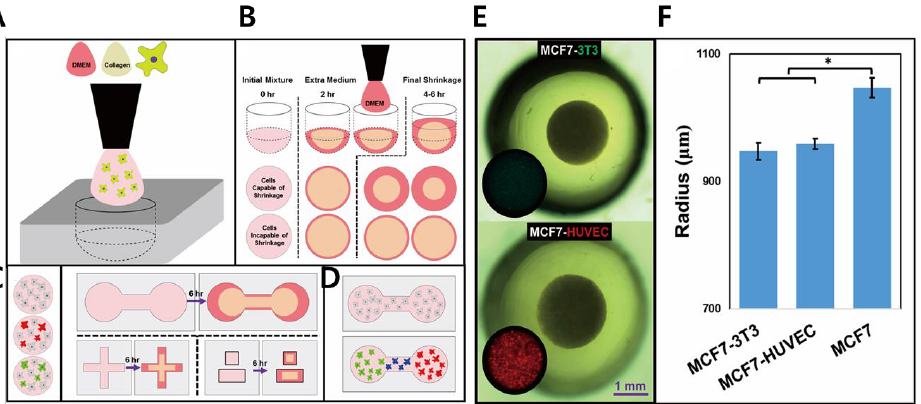
Figure 5. ( A ) Fabrication process of the collagen matrix platform. ( B ) Cell consolidation and shrinkage due to structural transformation and medium addition. ( C ) Creation of homogeneous co-culture structure with different morphologies (dumbbells, cuboids, and crosses). ( D ) Heterogeneous components formed by different cells at specific location of the molds. ( E ) Bright field and fluorescence microscopy of MCF-3T3 (green) and HUVEC (red) co-cultured with MCF7. ( F ) Calculated radius of a spheroid depending on cell type. ( p -values: * < 0.01). Reprinted with permission from [43]. Copyright 2019, Elsevier.